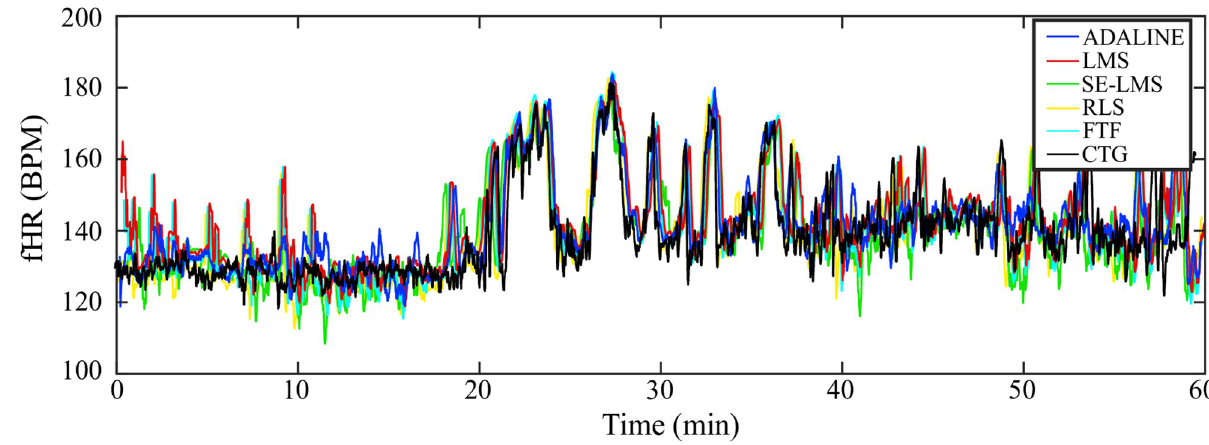
Fig 7. Comparison of the fHR trace estimated by means of different extraction methods and the CTG reference. The reference trace from CTG is marked black; the extraction algorithms are marked as follows: ADALINE (blue), LMS (red), SE-LMS (green), RLS (yellow), FTF (cyan).